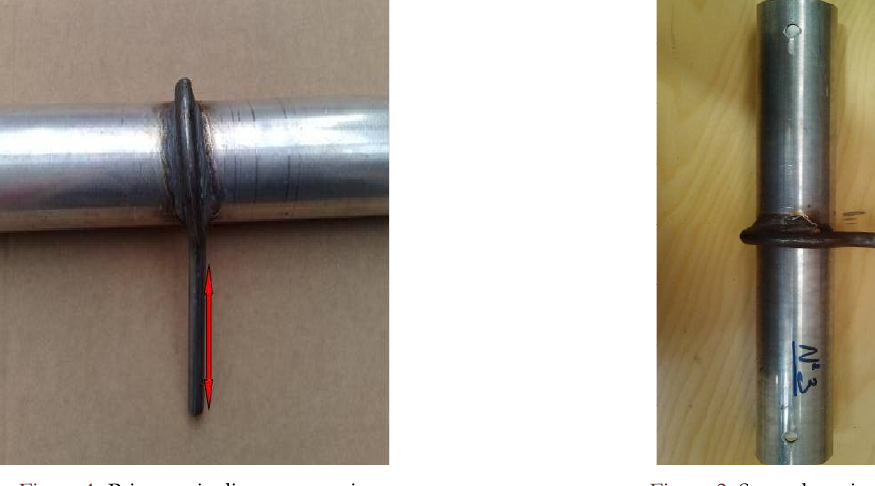
Figura 1: Prima serie di componenti Figura 2: Seconda serie di